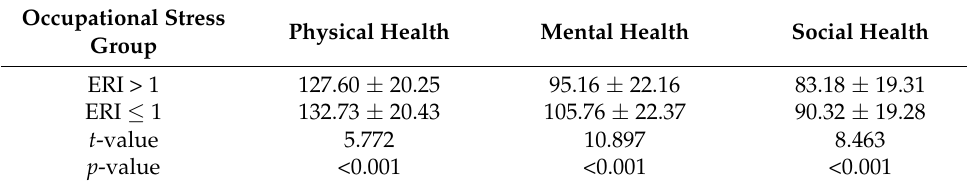
Table 4. Comparison of the SRHMS score among medical staff with an ERI score > 1 and ≤ 1.